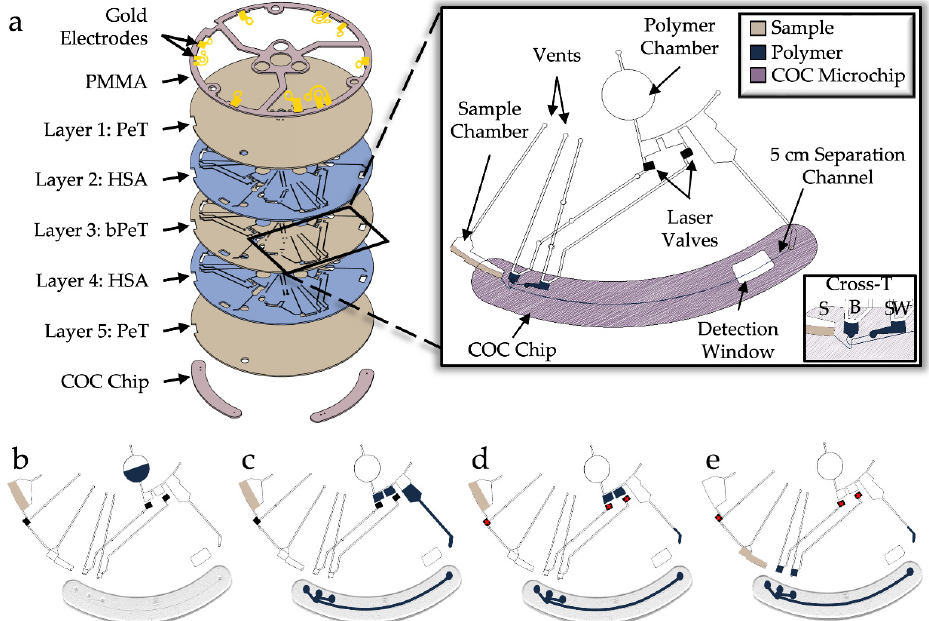
Figure 1. Design and architecture of µ EDisc for electrokinetic separation of amplified forensically relevant fragments. ( a ) An exploded view of the 5 layer microfluidic disc, comprising polyethylene terephthalate (PeT), heat sensitive adhesive (HSA), and black PeT with accessory pieces on the top and bottom of the disc, including poly(methyl methacrylate) (PMMA), gold electrodes, and an injection molded cyclic olefin copolymer (COC) separation chip. The inset shows a labeled schematic of an individual domain in the disc with a close-up of the separation cross-T and the sample (S), buffer (B), and sample waste (SW) reservoirs. Fluid was rotationally driven through the architecture in four simple steps: ( b ) sample and polymer were pipetted into the respective chambers and ( c ) polymer was centrifugally metered. ( d ) Laser valves were then opened (as indicated by a red ‘X’), and ( e ) the disc was spun to rotationally drive fluid into the S, B, and SW reservoirs.